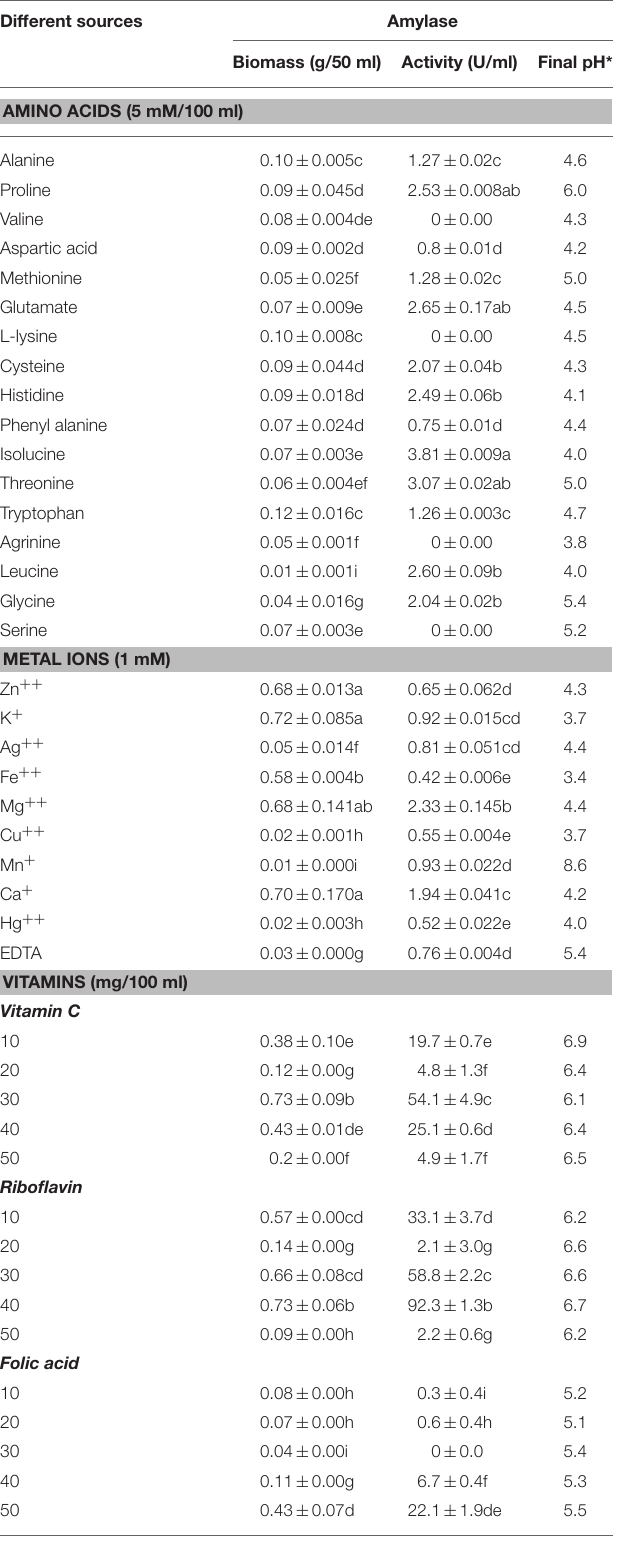
TABLE 3 | Effect of amino acids, metal ions, vitamins and growth regulators on amylase production by A. terreus NCFT 4269.10 a . Different sources